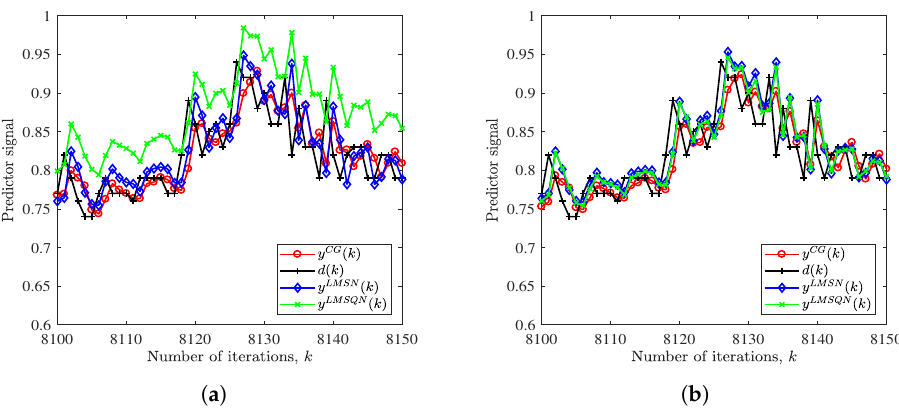
Figure 5. Simulation 2: Comparison between the desired signal and the predicted by the DS-CG, DS-LMSQN and DS-LMSN algorithms for ( a ) P up = 0.4 and ( b ) P up =